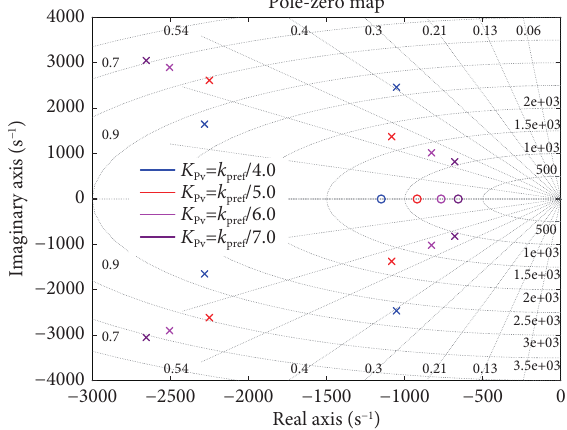
Fig. 11 The zero-pole distribution of the voltage loop, where m is